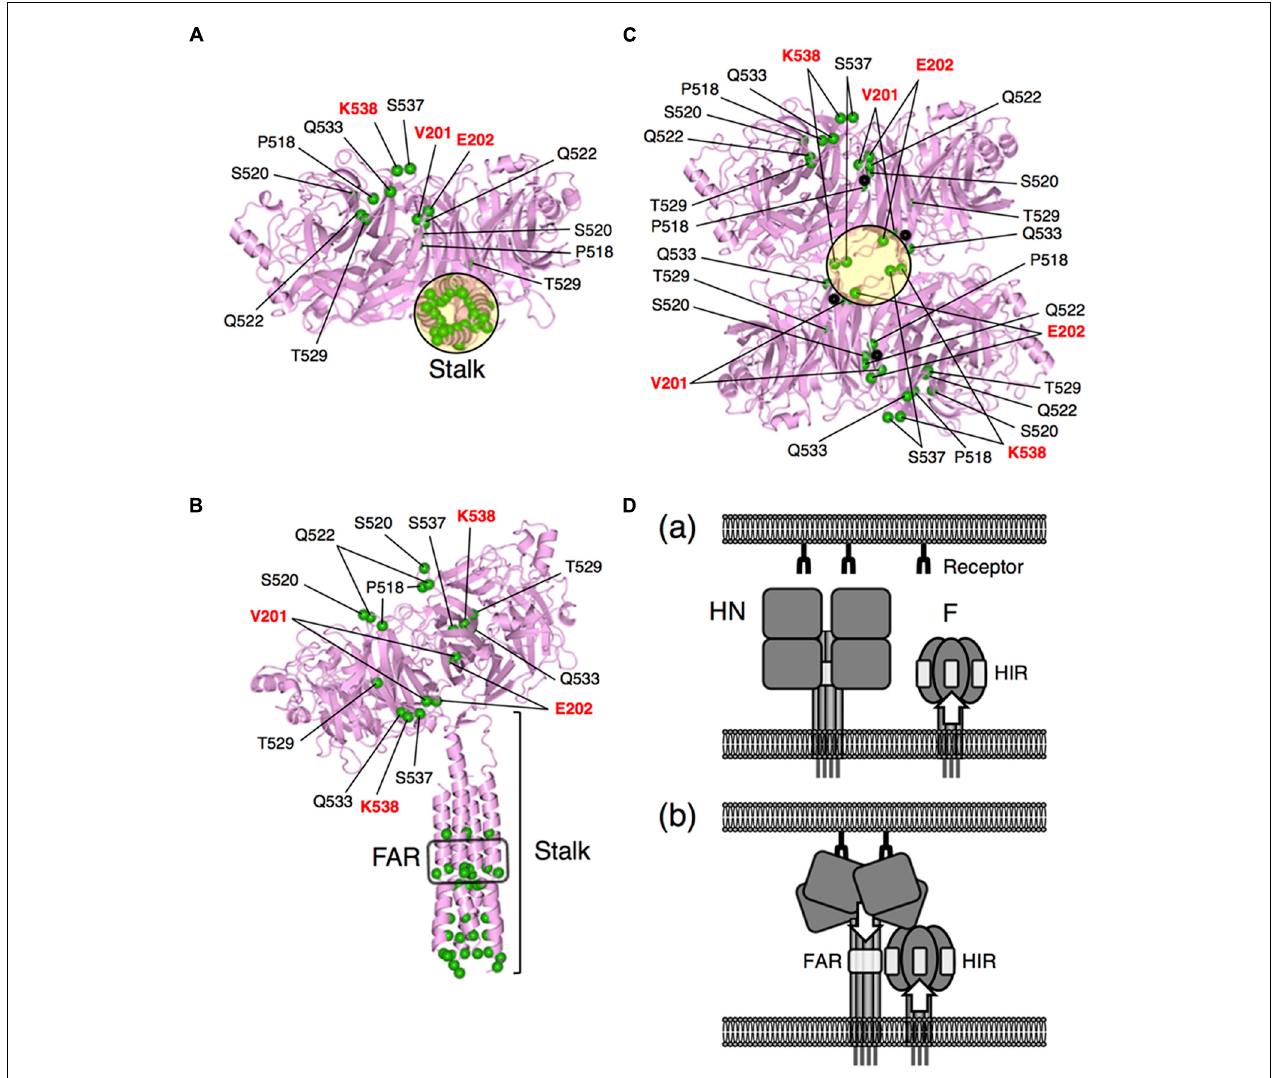
FIGURE 8 | Locations of the SV41 HN-derived amino acids in the SV41 HN-like chimera IM18-F. (A,B) Bottom (A) and side (B) views of IM18-F in the “2-heads-up/2-heads-down” conformation. The structures were drawn as ribbon models on the basis of the crystal structure (PDB ID: 4JF7) of the PIV5 (W3A) HN protein. The most amino-terminal residue in the model structure (ectodomain) is I62 in the stalk domain. The amino acid sequence identify between the ectodomains of IM18-F and the PIV5 HN protein is 47.3%. The head domains of the protomers which are in the down conformation are not shown. The positions of α -carbons of the SV41 HN-derived amino acids are indicated as green balls; in (A) , only four amino acids (residue numbers in the parentheses) of the right protomer can be seem because the remaining five are hidden behind the stalk domain. FAR, F-activating region. (C) Bottom view of the head domain of IM18-F in the “4-heads-up” conformation. The structure was drawn as a ribbon model on the basis of the crystal structure (PDB ID: 1Z4Z) of the “receptor bound form” of PIV5 (W3A) HN head domain. The position of the stalk domain is predicted to be at the center of the tetramer and indicated as a black circle as in (A) . The positions of α -carbons of the SV41 HN-derived amino acids are indicated as green balls. A black ball in each protomer indicates the α -carbons of the most amino-terminal residue L119 of the model structure. The amino acid sequence identify between the head domains of IM18-F and the PIV5 HN protein is 50.8%. (D) A hypothesis for the HN-F interaction. (a) Before receptor binding, the conformation of the HN-interacting region (HIR) in the F head domain is already modified if the F stalk domain has critical mutations. (b) After receptor binding, the HN protein undergoes a structural transition from the 4-heads-down conformation to the 4-heads-up conformation,